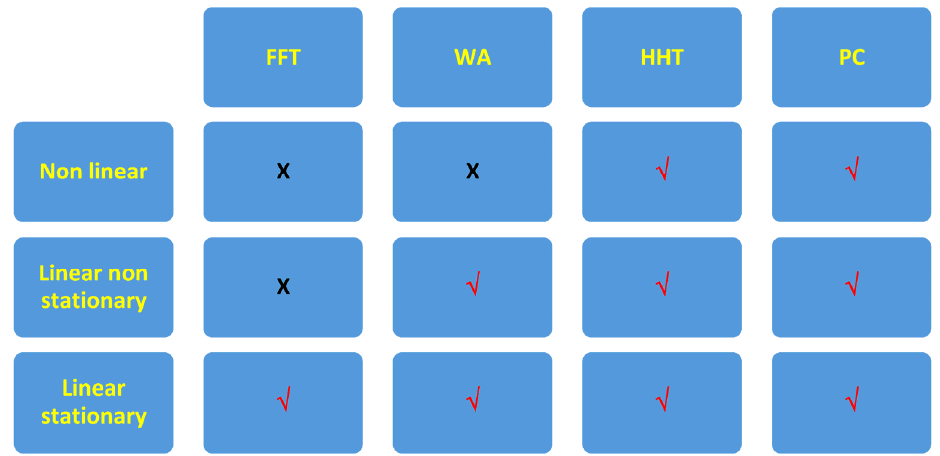
Figure 2. Methods to analyze electrical signals of Power Distribution Systems (PDS) with PhotoVoltaic (PV) plants. (× = not applicable; √ = applicable).